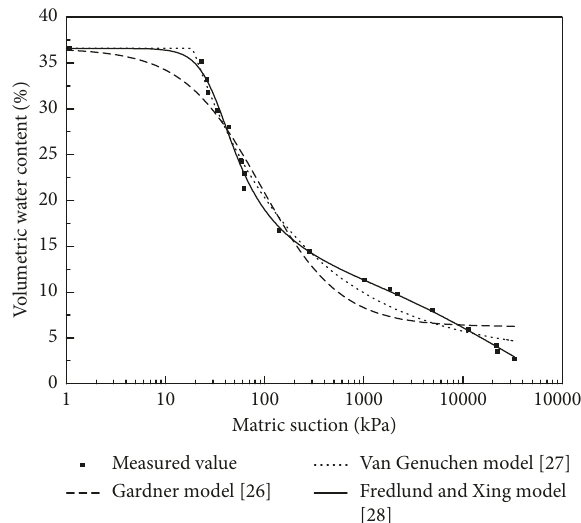
Figure 8: Typical result for the loess compacted at optimum water content (wetting